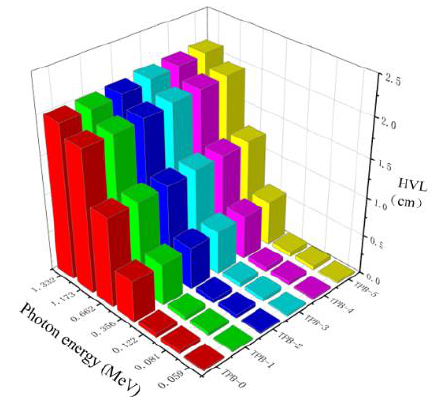
Figure 6. Comparison between the mean free path (MFP) for the TPB glasses with different radiation shielding glass. 4.5. Effective Atomic Number The theoretically calculated effective atomic number Z eff of the TPB glass is shown in Figure 7. The Z eff value is an indispensable parameter in the study of gamma shielding, and it is another key factor in radiation physics. The magnitude of the Z eff value reflects the gamma attenuation ability of the absorbent material. Objects with large Z eff values are the preferred targets for more collisions of photons, so photons are highly attenuated in these materials. In actual shielding applications, anti-radiation glass with a high Z eff value is more reliable for shielding gamma radiation.